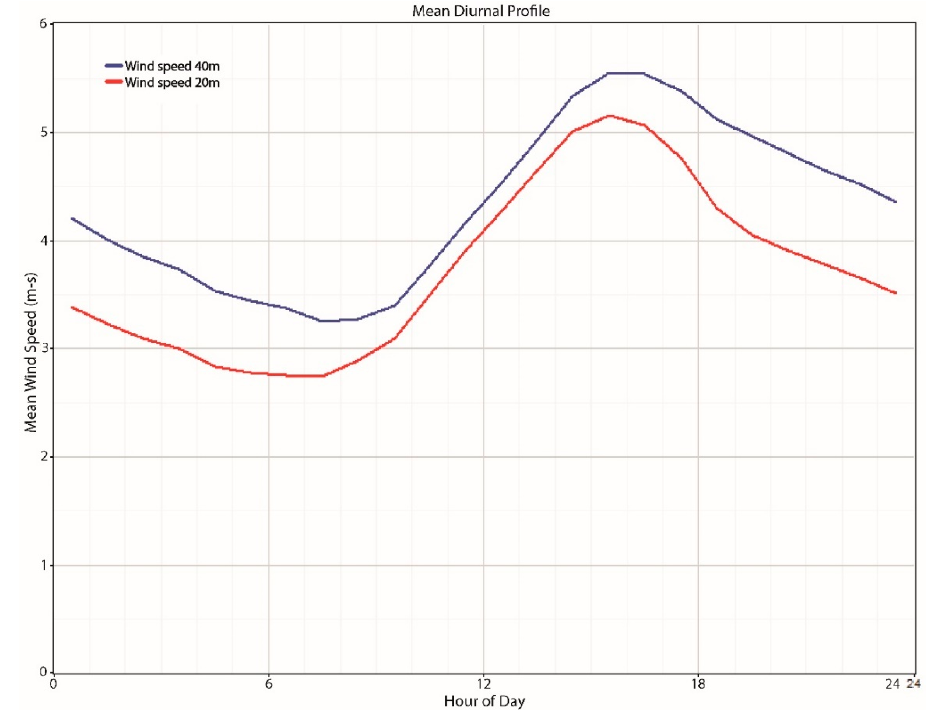
Figure 6. Mean diurnal profile of wind speed. Source: generated by the software. Appl. Sci. 2019 , 9 , x FOR PEER REVIEW